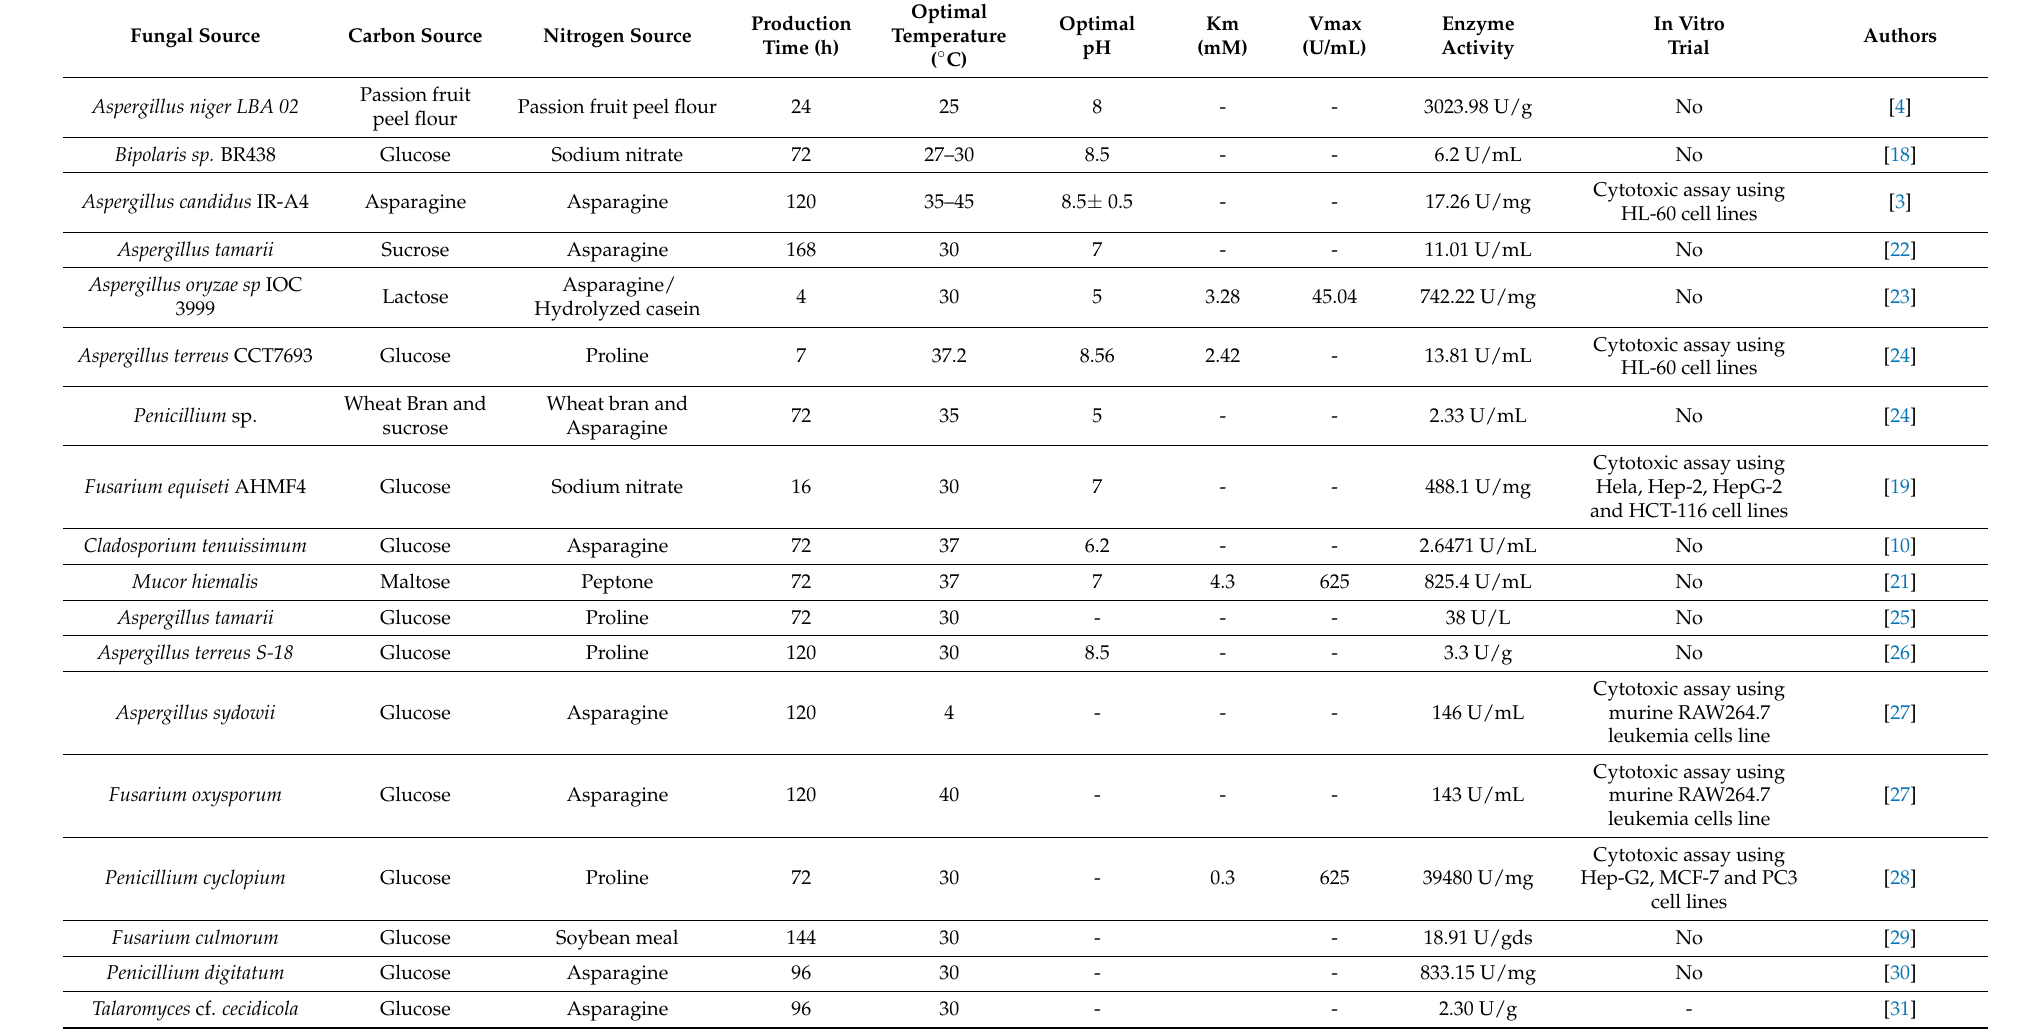
Table 1. L-asparaginases production by filamentous fungi: cultivation conditions and biochemical